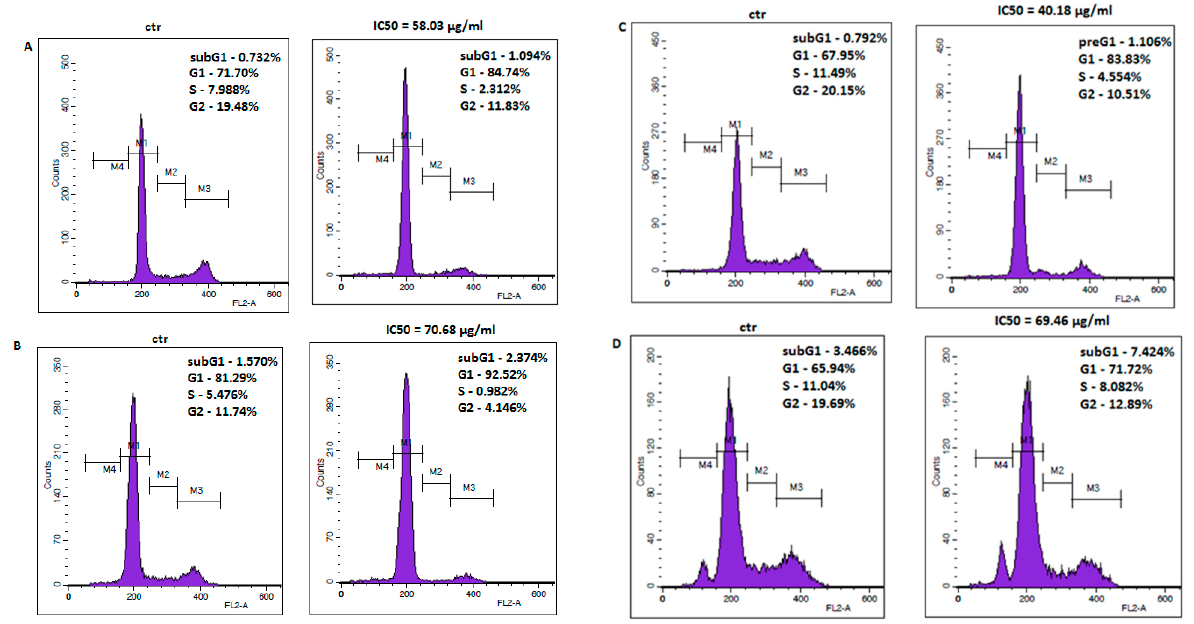
Figure 5. Representative flow cytometry histogram peaks of the A375 ( A ), SK-MEL28 ( B ), FM55P ( C ) and FM55M2 ( D ) melanoma cell lines after the treatment with a medium (ctr) and amantadine at an IC 50 concentration for 72 h. Region M1, M2, M3 and M4 included G1, S, G2 and subG1 phase, respectively.